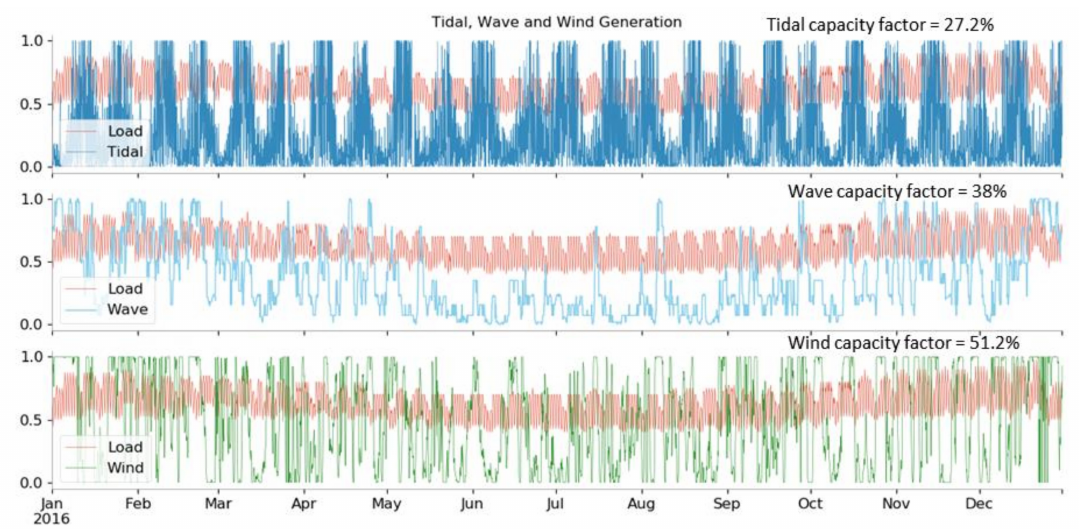
Figure 3. Generation profiles for resources located o ff North Ronaldsay for the year 2016. Generation is plotted as a proportion of maximum output. The load profile for the studied network is also plotted as a proportion of maximum demand (red dashed line).